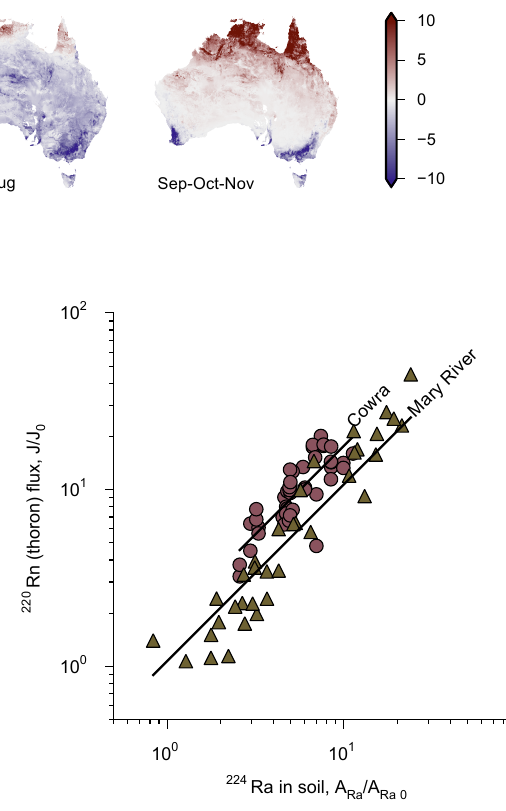
Fig. 12. Observed correlation between radium-224 specific ac- tivity, as determined from field radiometrics using the thorium channel, and radon-220 (thoron) flux. The lines of best fit are y = 1 . 8 x ( R 2 = 0 . 55, circles mark measurements) for Cowra and y = 1 . 1 x ( R 2 = 0 . 79, triangles mark measurements) for Mary River. Radium-224 activity is normalised by A Ra0 = 30Bqkg − 1 and flux by J 0 = 1 . 7Bqm 2 s − 1